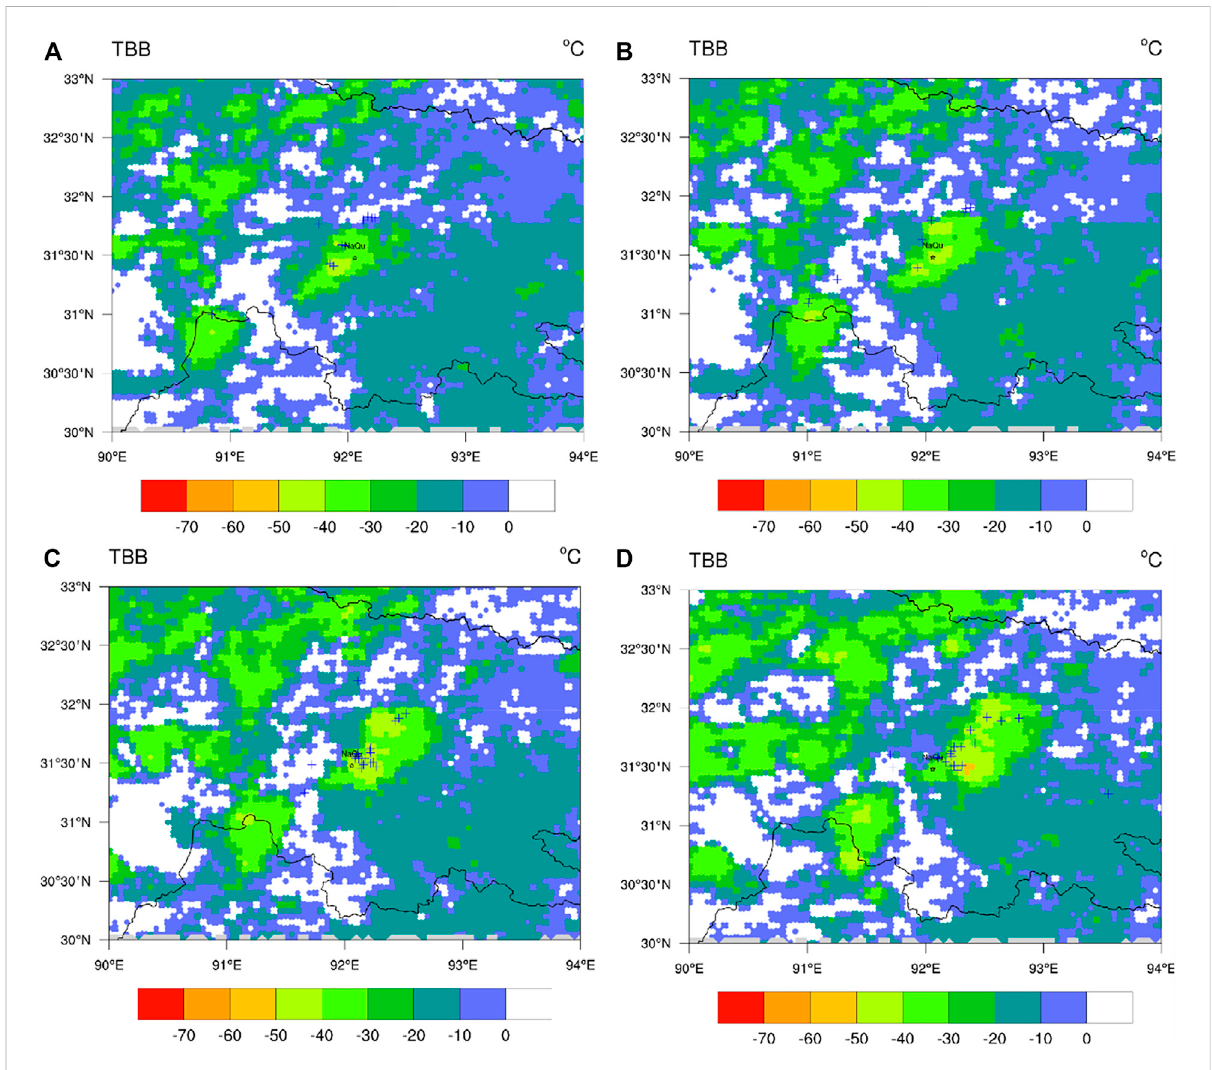
FIGURE 10 TBBsuperimposedonCGlightningat (A) 0,500, (B) 0,520, (C) 0,540,and (D) 0600UTConJuly16(+indicatesnegativeCGlightning, ⊕ indicates positive CG